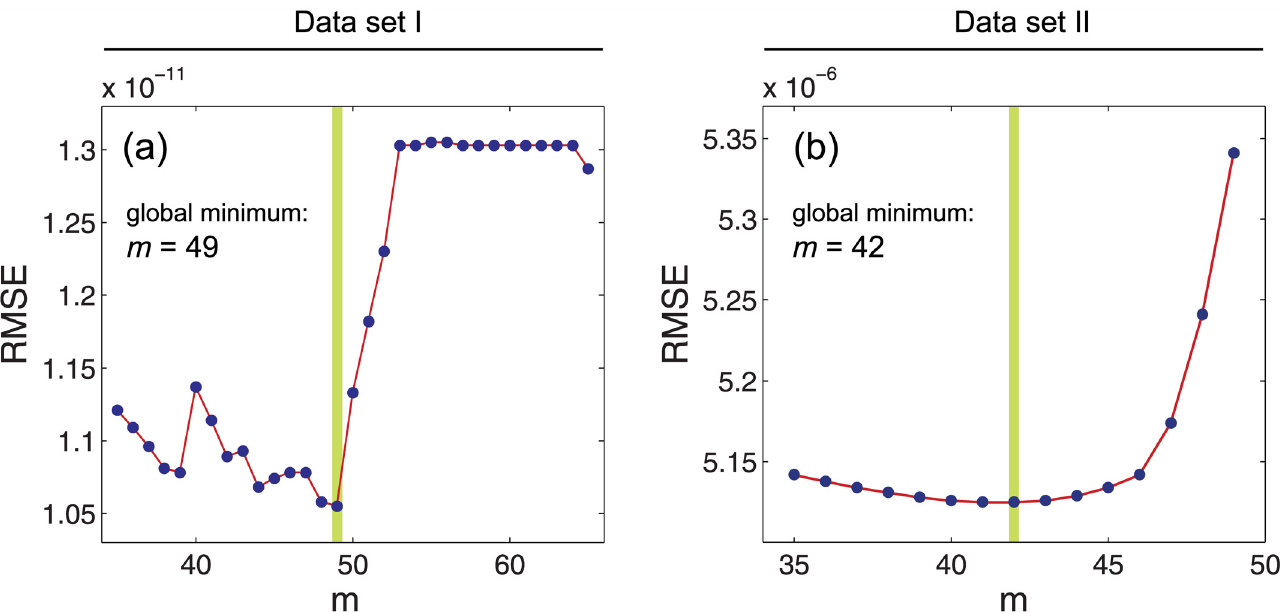
Fig 2. A robust nonlinear least squares fitting withthe least absolute residuals (LAR) method and the Levenberg-Marquardt algorithm (LMA) are used to obtain the RMSE values for the curve fitting with the Eq (2) for T = 296 K, performed on the rods in the data set I (a), and cones in the data set II (b). The global minima are highlighted as green vertical lines where m = 49 is obtained for rods and m = 42 is obtained for cones.